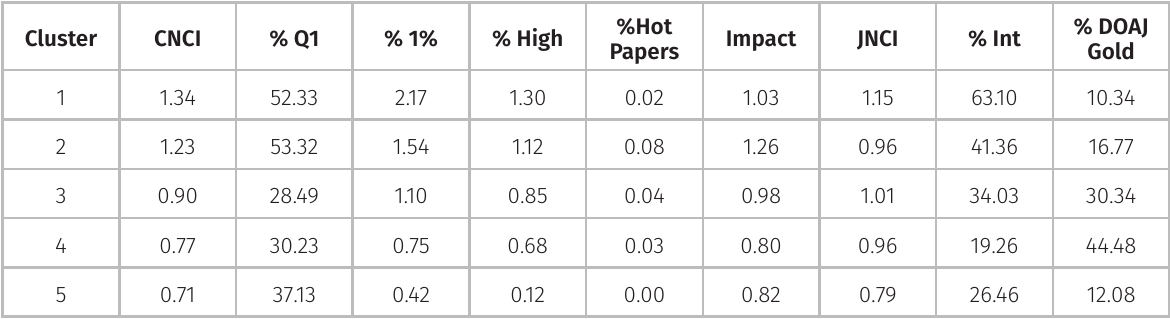
Table II. Means for selected quality indicators for research institutions and centres in Brazil. Cluster